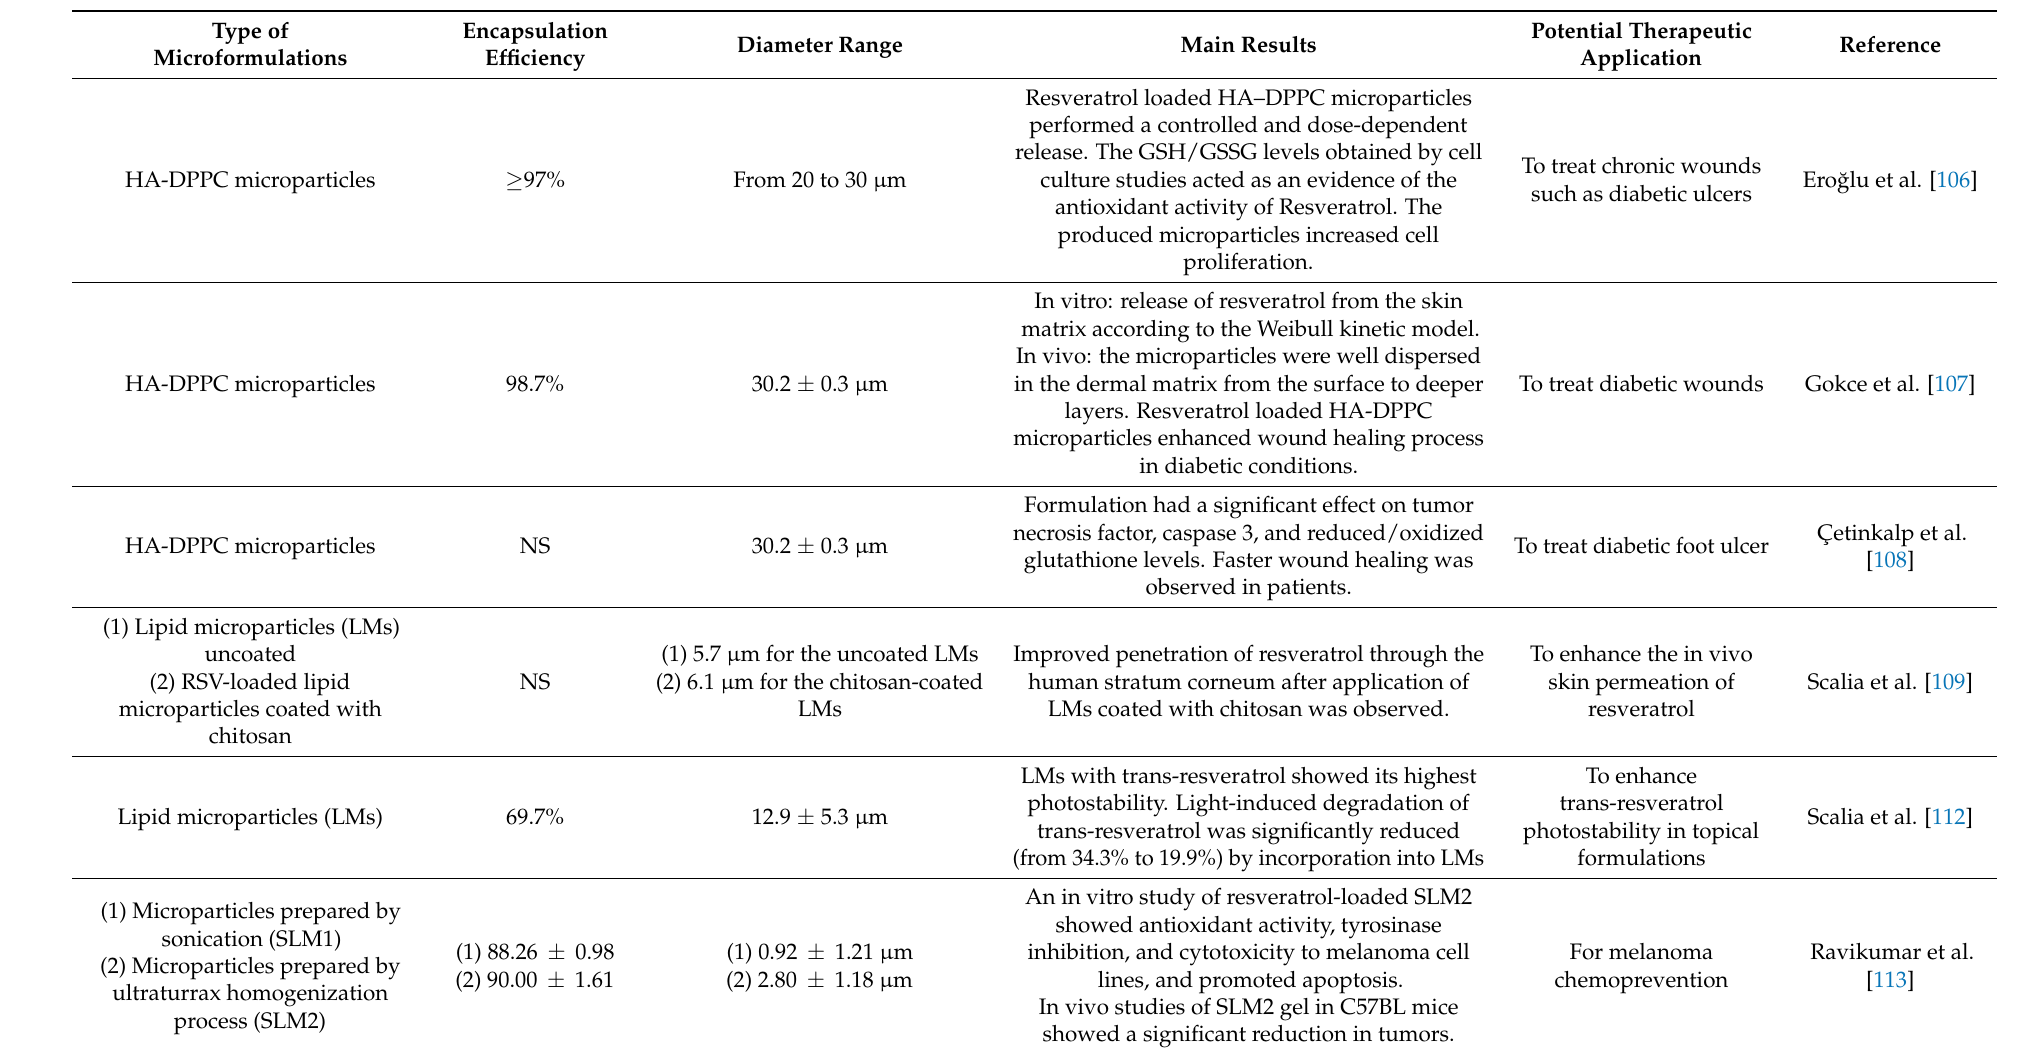
Table 2. Microformulations of resveratrol for topical